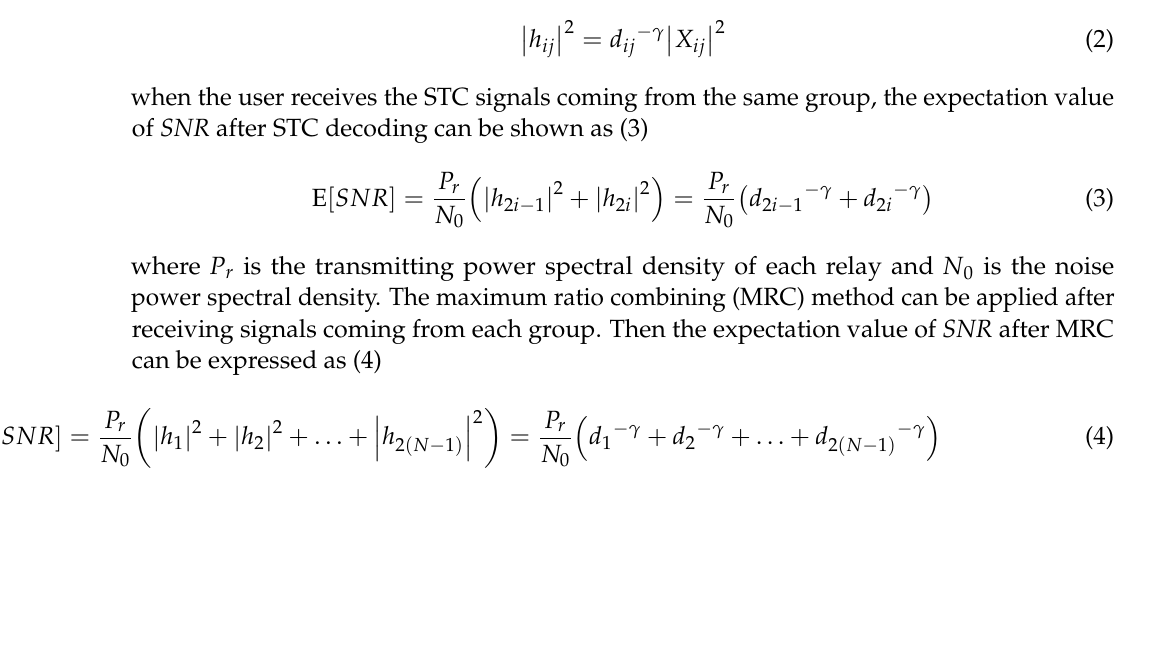
where d ij denotes the distance between the i -th station and the j -th user, and γ is the path loss exponent, which is equivalent to 2 in this paper. The fading X ij , is assumed to be an independent identical (i.i.d.) Rayleigh random variable with a unit variance. Combining the propagation path loss and the fading, the channel link gain h ij can be represented as (2).